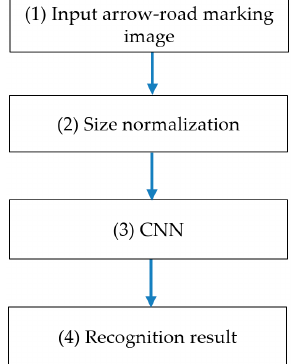
Figure 1. Overall flowchart of proposed method.